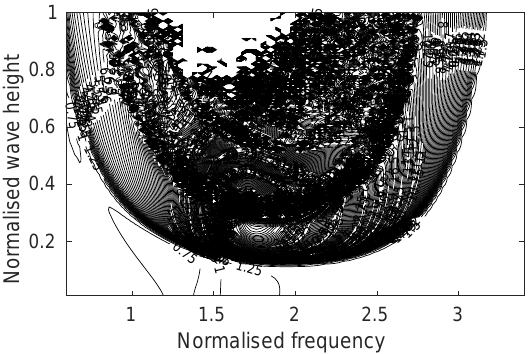
Figure 10. The energy increase in the pitch displacement from the start to the end of the simulation as a function of the normalised wave frequency and height. The contour lines have a resolution of 0.25.